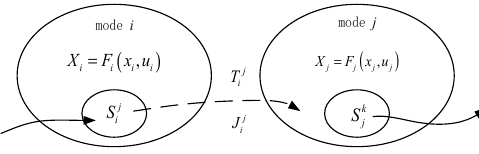
Figure 5. Hybrid systemtransitionmodel.